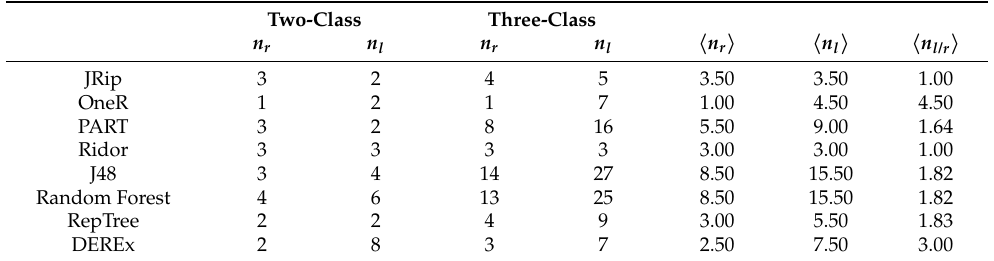
Table 9. Size of information extracted by the classifiers performing interpretable machine learning. Two-Class Three-Class n